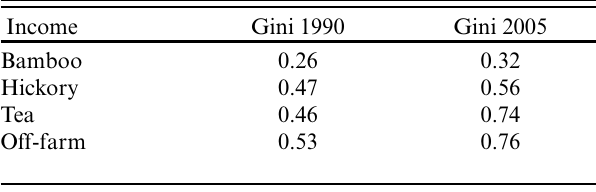
Table 1 . Changes in Gini coefficients for main sources of income in Daxi village between 1990 and 2005 (unpublished statistics for 1990 obtained from the Daxi village's handwritten notebooks; statistics for 2005 from Gutierrez et al.